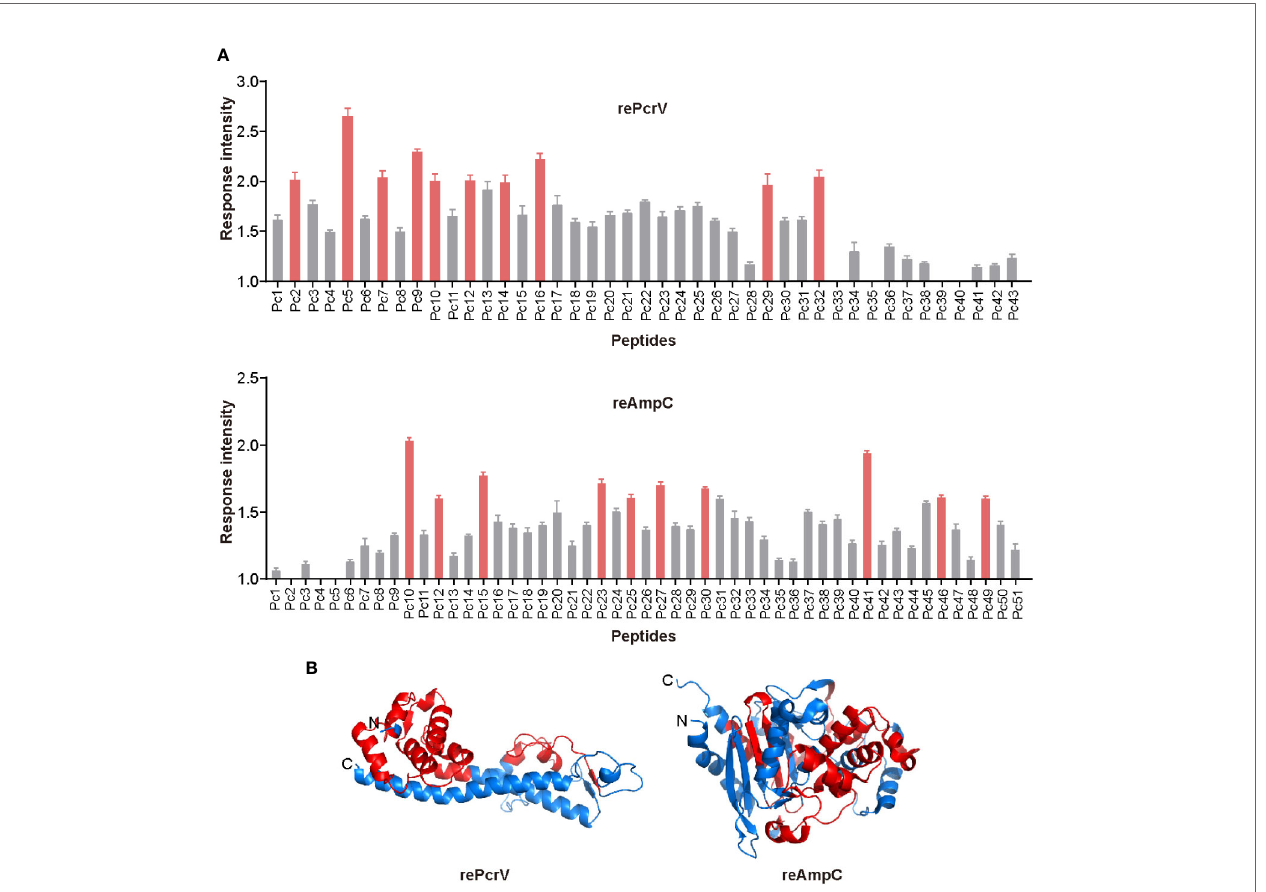
FIGURE 5 | Mapping of epitopes in rePcrV and reAmpC that stimulate a Th17 response. (A) The lung lymphocytes of mice immunized with rePcrV (upper) and reAmpC (lower) were isolated and cocultured with the corresponding peptide library. The number of IL-17 − secreting cells induced by each peptide was detected by ELISpot. The bars represent the mean and SE of the fold increase in SFCs (spot-forming cells). The top ten peptides are shown in red. (B) Cartoon image of the 3D structure of PcrV (left) and AmpC (right). The model of PcrV was built with the I-TASSER Suite, while the model of AmpC was obtained from the Protein Data Bank (PDB: 4GZB). The images were generated with PyMol 2.4 software. The regions corresponding to the top ten peptides are shown in red. The Th17-stimulating epitopes in rePcrV accumulated at its N-terminus, while those of reAmpC spanned the whole